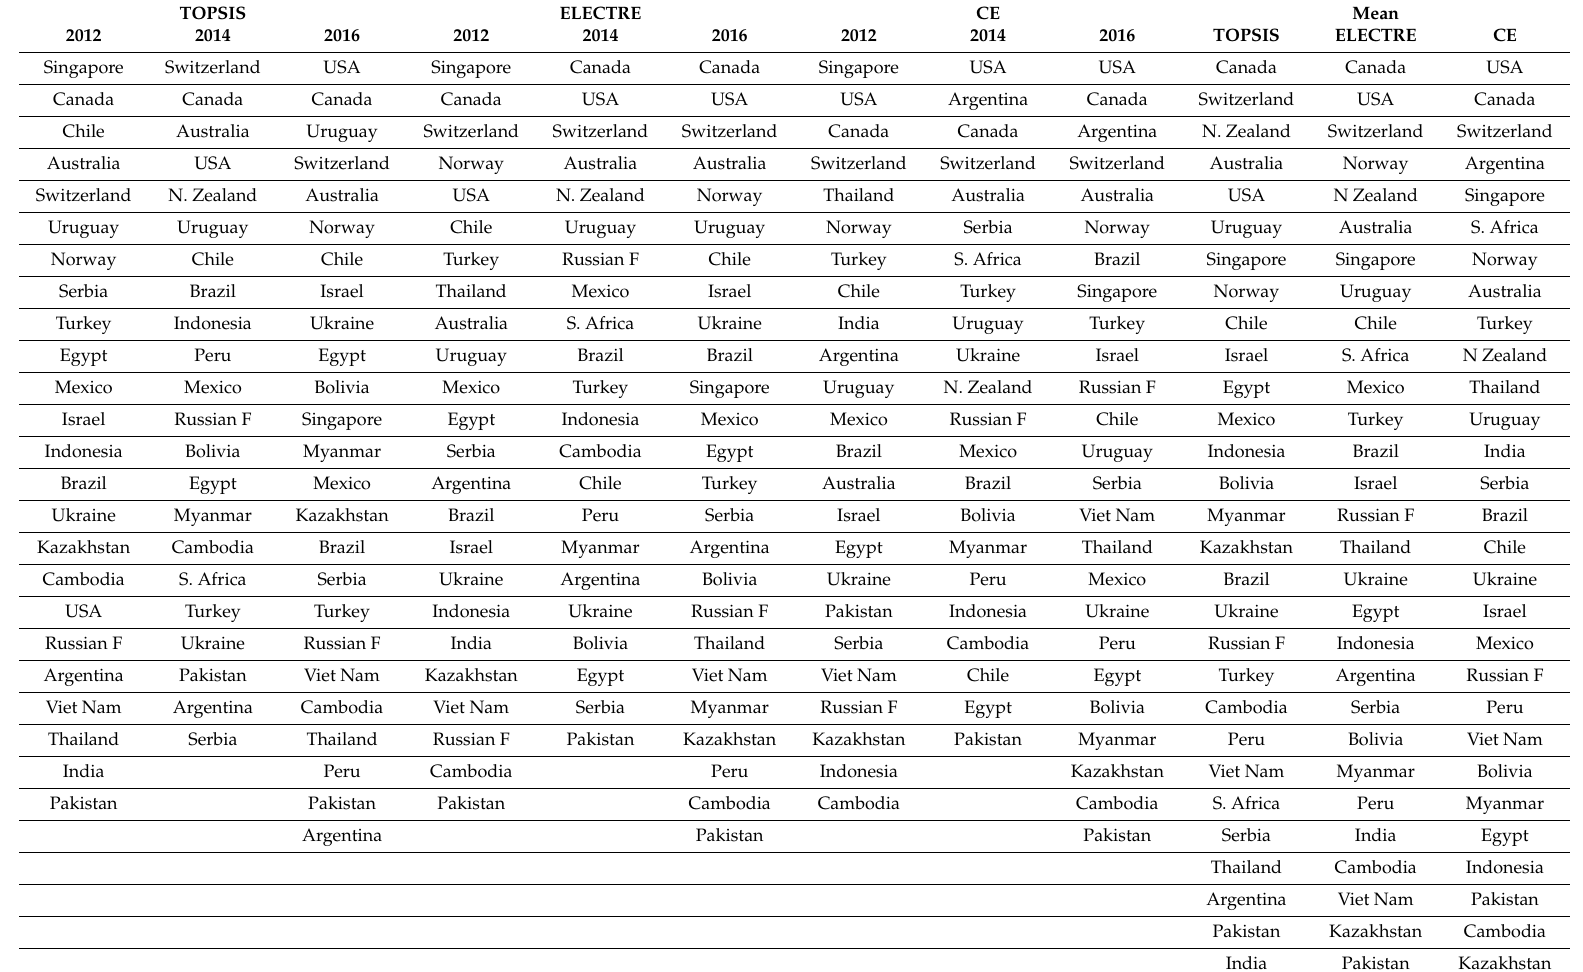
Table 6. Ranking of cereal suppliers to the